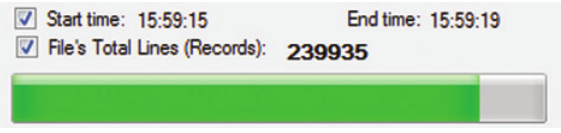
Figure 4. Analysis Process Progress